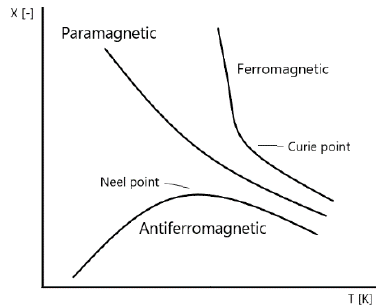
Figure 6. Magnetic susceptibility vs. temperature curve.